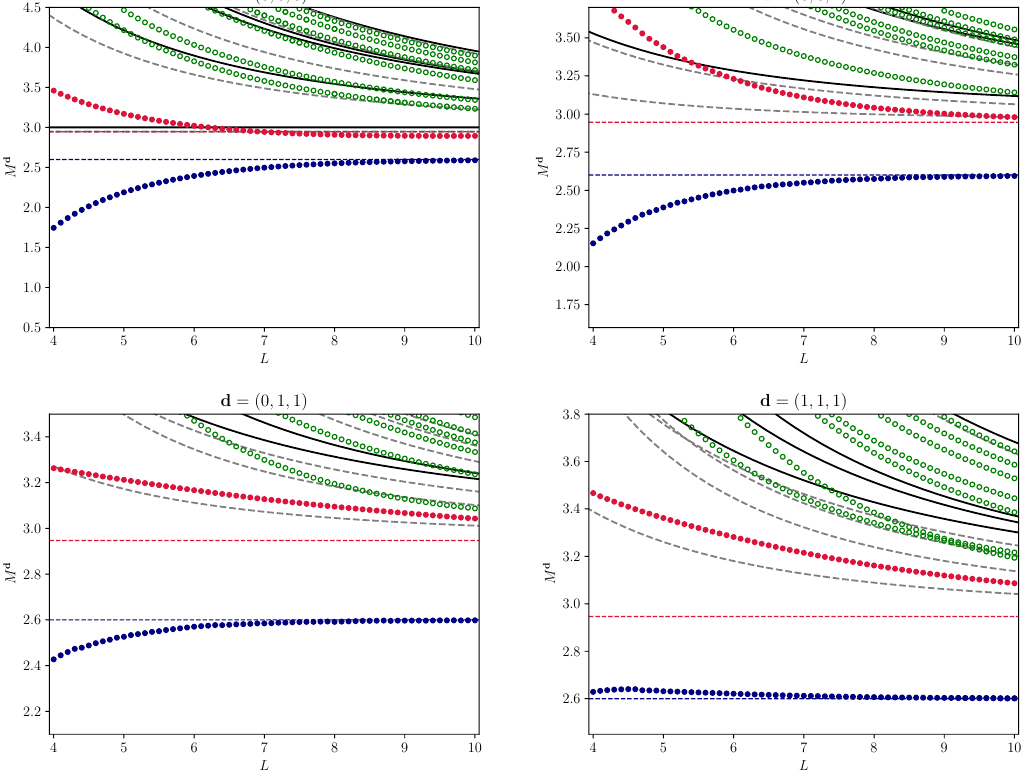
Figure 5 . Dependence of the energy levels on the box size L in the rest frame and moving frames. Blue and red dotted curves correspond to the energy of the deep and shallow bound states, respectively, and the green dotted curves denote the so-called scattering states. The solid black lines and the gray dashed lines represent the energies of three free particles and a free particle-dimer system in a finite volume, respectively. Horizontal blue and red dashed lines indicate the energies of the infinite-volume deep and shallow bound states. One observes an avoided level crossing (related, presumably, to the crossing of the free particle-dimer levels) in the frame d = (1 , 1 , 1) but not in the other frames. Thus, this is a purely kinematic